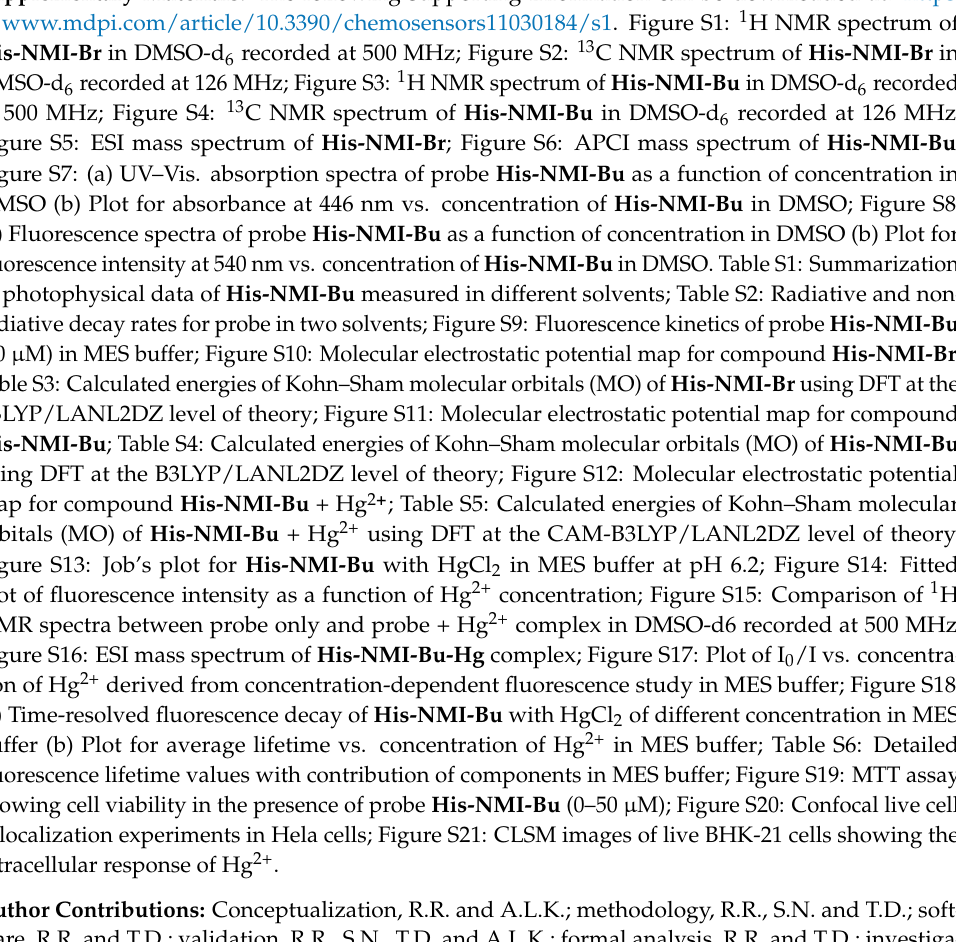
Figure S5: ESI mass spectrum of His-NMI-Br ; Figure S6: APCI mass spectrum of His-NMI-Bu ; Figure S7: (a) UV–Vis. absorption spectra of probe His-NMI-Bu as a function of concentration in DMSO (b) Plot for absorbance at 446 nm vs. concentration of His-NMI-Bu in DMSO; Figure S8: (a) Fluorescence spectra of probe His-NMI-Bu as a function of concentration in DMSO (b) Plot for fluorescence intensity at 540 nm vs. concentration of His-NMI-Bu in DMSO. Table S1: Summarization of photophysical data of His-NMI-Bu measured in different solvents; Table S2: Radiative and non- radiative decay rates for probe in two solvents; Figure S9: Fluorescence kinetics of probe His-NMI-Bu (10 µ M) in MES buffer; Figure S10: Molecular electrostatic potential map for compound His-NMI-Br ; Table S3: Calculated energies of Kohn–Sham molecular orbitals (MO) of His-NMI-Br using DFT at the B3LYP/LANL2DZ level of theory; Figure S11: Molecular electrostatic potential map for compound His-NMI-Bu ; Table S4: Calculated energies of Kohn–Sham molecular orbitals (MO) of His-NMI-Bu using DFT at the B3LYP/LANL2DZ level of theory; Figure S12: Molecular electrostatic potential map for compound His-NMI-Bu + Hg 2 + ; Table S5: Calculated energies of Kohn–Sham molecular orbitals (MO) of His-NMI-Bu + Hg 2+ using DFT at the CAM-B3LYP/LANL2DZ level of theory; Figure S13: Job’s plot for His-NMI-Bu with HgCl 2 in MES buffer at pH 6.2; Figure S14: Fitted plot of fluorescence intensity as a function of Hg 2+ concentration; Figure S15: Comparison of 1 H NMR spectra between probe only and probe + Hg 2+ complex in DMSO-d6 recorded at 500 MHz. Figure S16: ESI mass spectrum of His-NMI-Bu-Hg complex; Figure S17: Plot of I 0 /I vs. concentra- tion of Hg 2+ derived from concentration-dependent fluorescence study in MES buffer; Figure S18: (a) Time-resolved fluorescence decay of His-NMI-Bu with HgCl 2 of different concentration in MES buffer (b) Plot for average lifetime vs. concentration of Hg 2+ in MES buffer; Table S6: Detailed fluorescence lifetime values with contribution of components in MES buffer; Figure S19: MTT assay showing cell viability in the presence of probe His-NMI-Bu (0–50 µ M); Figure S20: Confocal live cell colocalization experiments in Hela cells; Figure S21: CLSM images of live BHK-21 cells showing the intracellular response of Hg 2+